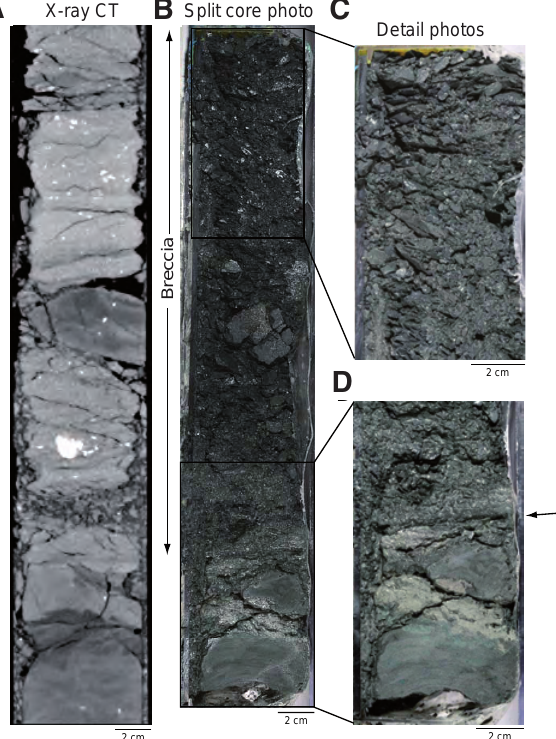
Figure 5. Fault core example from the frontal thrust region at Site C0007 (Expedition 316). Appearance of concentrated deformation in lower portion of frontal thrust fault Zone 3, at a depth of 438 mbsf. [A] CT image and [B] core photograph of finely brecciated hemipelagic mudstone (interval 316-C0007D-29R-2, 37–73 cm). [C] Close-up of finely brecciated interval. [D] Thin (2-mm-thick) dark layer (arrow) developed at base of finely brecciated